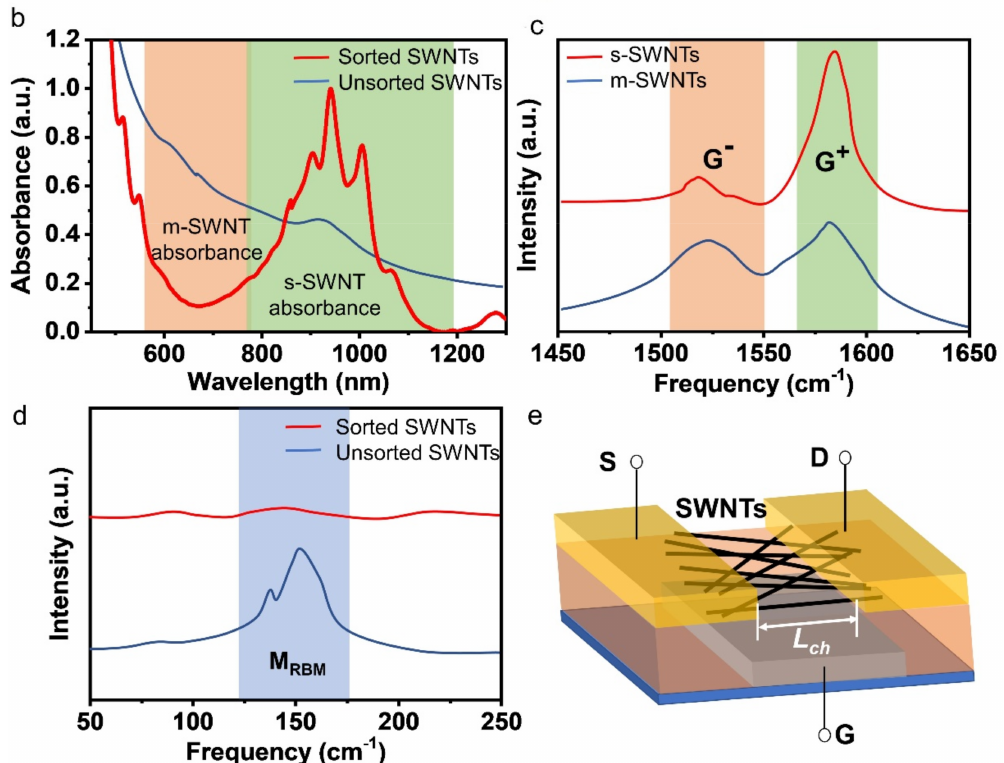
Figure 2. ( a ) Basic process of the conjugated polymer wrapping method for selectively dispersing s-SWNTs. During the sonication process, polymer will wrap around the SWNTs. Polymer-wrapped m-SWNTs tend to bundle together and form precipitation after centrifugation, leaving the sorted and individualized s-SWNTs in the supernatant; ( b ) UV-Vis-IR spectroscopy of sorted and unsorted SWNTs. The purity of s-SWNTs can be evaluated by comparing the absorption bands of m-SWNTs (typically between 600 nm and 800 nm for arc discharge SWNTs) and the S 22 absorption band of s-SWNTs (typically between 800 nm and 1200 nm for arc discharge SWNTs). The absorbance of m-SWNTs significantly reduced after the sorting process; ( c ) Raman spectroscopy measurement for the G peaks of SWNTs which is split into two types: G + and G − . G + is induced by atomic displacement along the tube axis, while G − is induced by the displacement along the circumferential direction of the tube. The G − peak of m-SWNTs is stronger and wider than that of s-SWNTs, because m-SWNTs have more free electrons; ( d ) Raman spectroscopy for radial breathing mode (RBM) vibration peaks of SWNTs. Under certain excitation wavelengths, the signals from m-SWNTs disappear after sorting (peaks in the range of 140–190 cm –1 come from m-SWNTs under 785 nm excitation); ( e ) schematic diagram